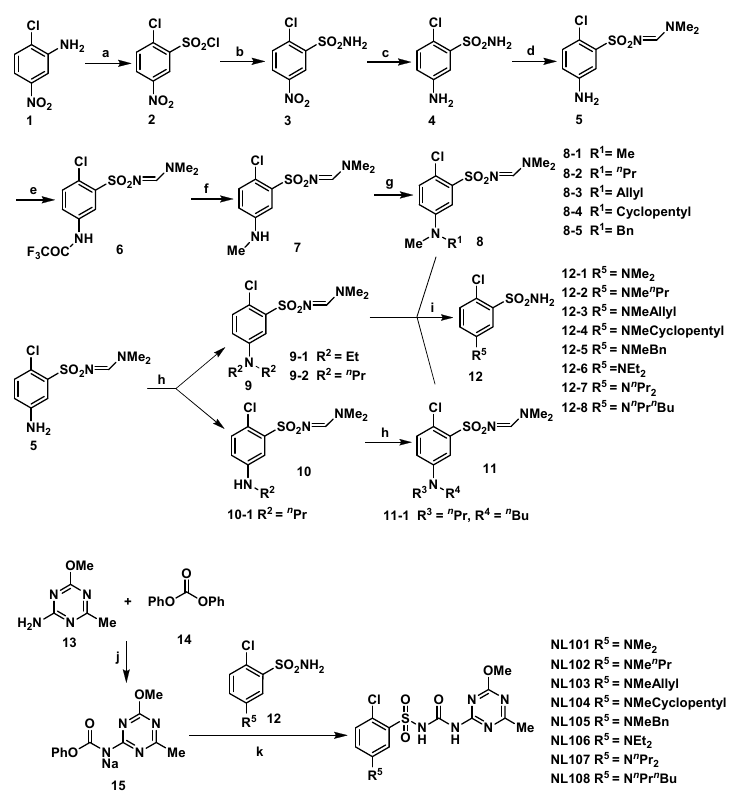
Figure 3. The synthesis of 5-dialkylamino-substituted compounds. Reagents and conditions: (a) H 2 O, HCl, NaNO 2 → H 2 O, HCl, CuCl 2 , NaHSO 3 , − 5 ◦ C; (b) 28% NH 3 · H 2 O, THF, 0 ◦ C → RT (room tem- perature), overnight; (c) Fe, HCl, C 2 H 5 OH, H 2 O, reflux; (d) DMF-DMA (N,N-dimethylformamide dimethyl acetal), CH 2 Cl 2 ; (e) TFAA (trifluoroacetic anhydride), CH 2 Cl 2 , 0 ◦ C; (f) ICH 3 , K 2 CO 3 , DMF, 50 ◦ C; (g) Haloalkane, K 2 CO 3 , CH 3 CN, reflux; (h) Haloalkane, K 2 CO 3 , CH 3 CN, reflux; (i) 80% H 2 NNH 2 · H 2 O, C 2 H 5 OH; (j) 60% NaH, THF, 0 ◦ C → RT; (k) DBU (1,8-Diazabicyclo[5.4.0]undec-7- ene), CH 3